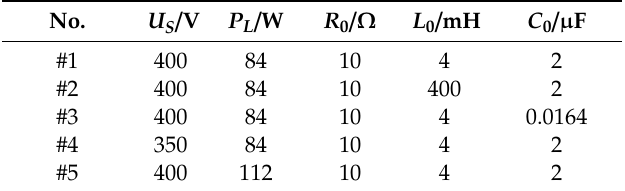
Table 4. Five Saber parameter sets for large-signal stability simulation of a single-node CSO undersea DC power